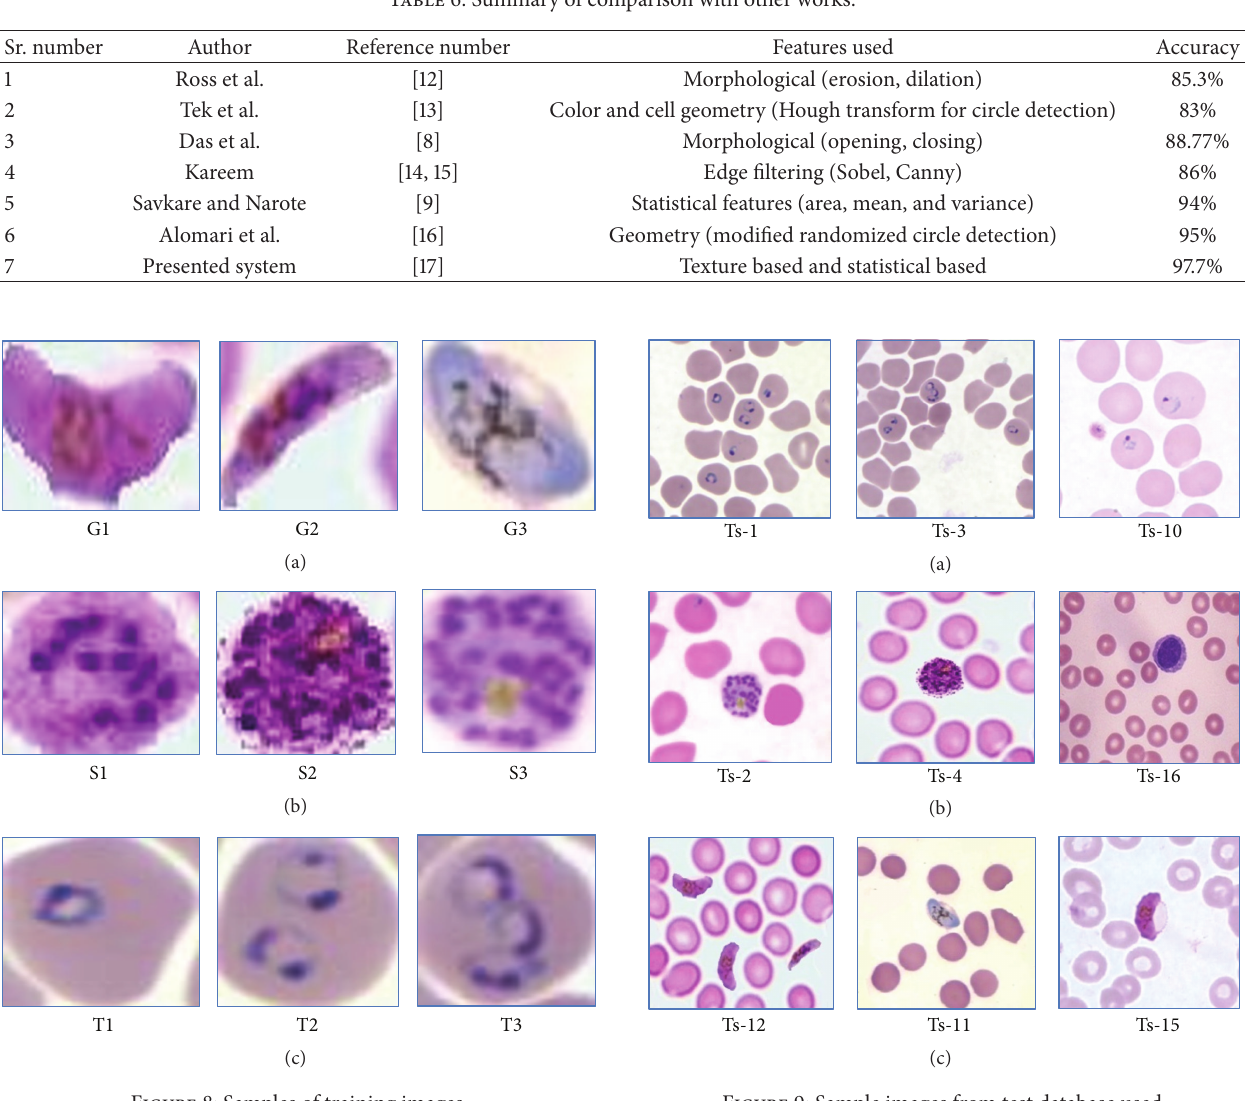
Figure 8: Samples of training images. Figure 9: Sample images from test database